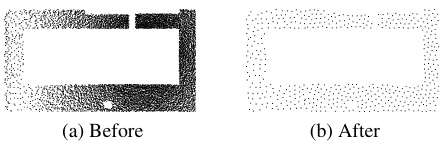
Figure 10. Test data prepared for ICP